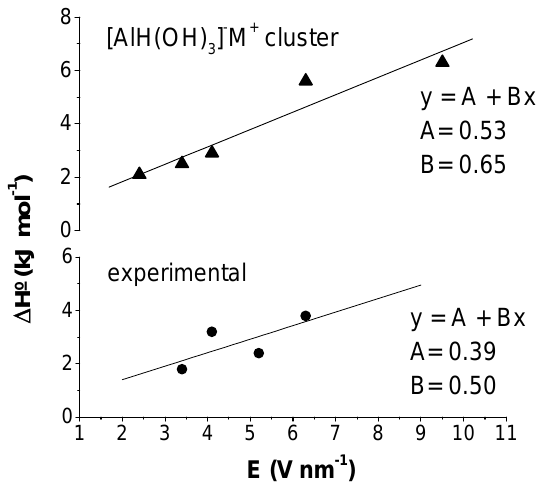
Figure 4. Plots of isomerization enthalpy versus electric